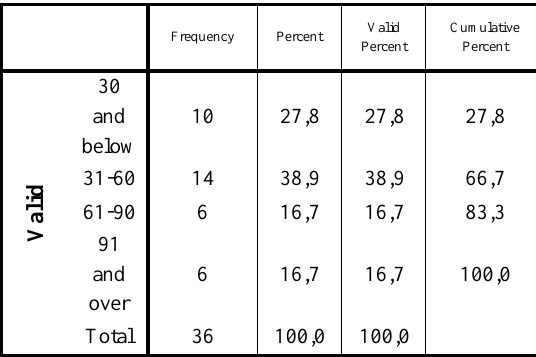
Table 10: Opinions of Accounting